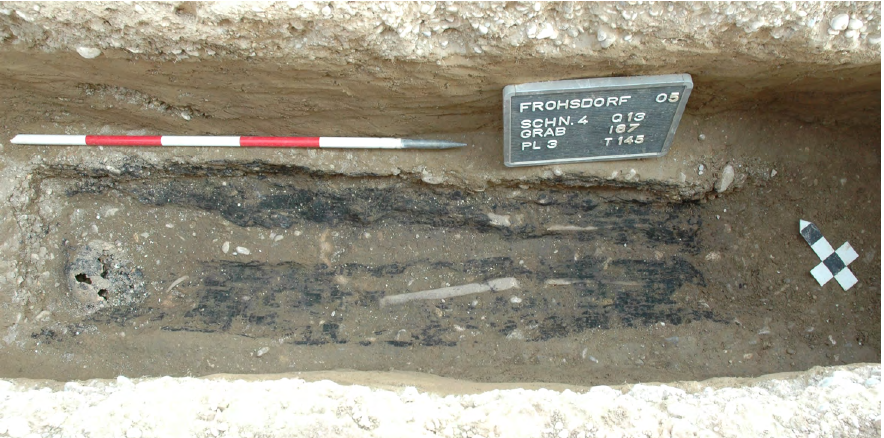
Figure 3: Grave 187 with longitudinal planks of the coffin lid (photo: Nicole